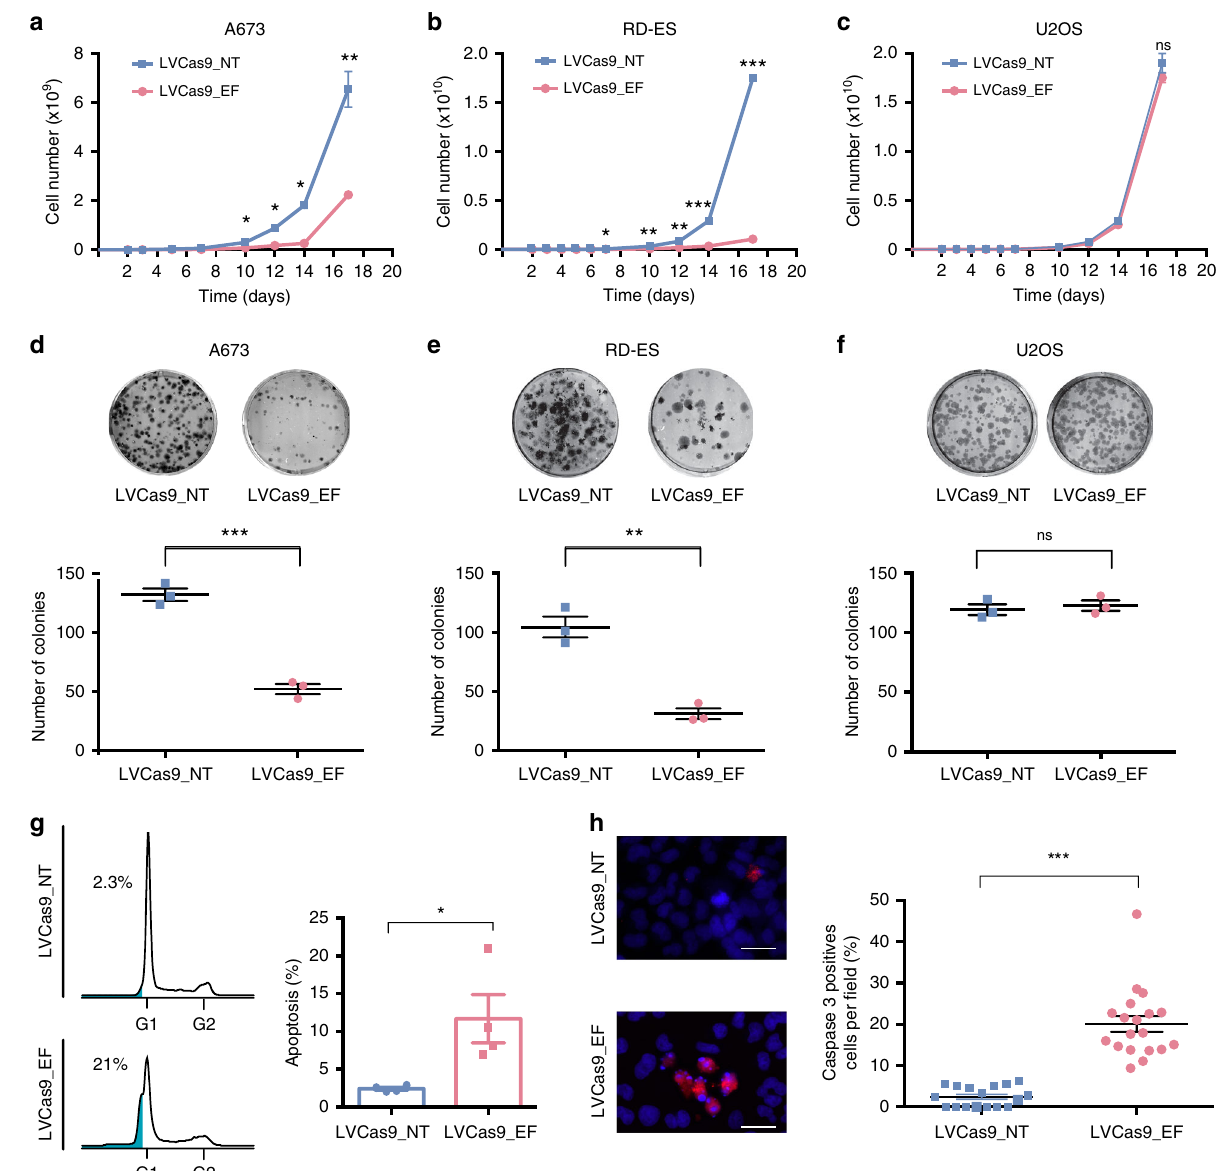
Fig. 2 CRISPR-mediated targeting of EWSR1-FLI1 inhibits in vitro cell growth. a – c Growth rate assay curves of A673 (** p = 0.01), RD-ES (*** p = 0.0005) and U2OS edited (LVCas9_EF) and control (LVCas9_NT) cells. ( n = 6 independent experiments). d – f Representative crystal violet staining of A673 (*** p = 0.0003), RD-ES (** p = 0.0017) and U2OS experimental and control cells. Bottom panels show the statistical analysis of the number of colonies. ( n = 3 independent experiments). g Left panel shows DNA pro fi le analysis by propidium iodide staining and fl ow cytometry. FlowJo v10.0.7 fl ow cytometry analysis of DNA fragmentation by subG1 population (cells with fragmented DNA) quanti fi cation. The percentage of cellular apoptosis was calculated using the percentage of the subG1 peak. Right panel shows graphical representation of subG1 analysis. ( n = 4 independent experiments) * p = 0.027. h Representative images of caspase-3-immunostained A673 cells. Scale bars, 50 μ m. Right panel shows the percentage of caspase-3-positive cells per fi eld analyzed. ( n = 520 (LVCas9_NT) and n = 613 (LVCas9-EF) cells examined over three independent experiments), *** p = 1.07e-9. The error bars indicate the s.e.m. for the averages across the multiple experiments; p -values are represented (ns non-signi fi cant; * p ≤ 0.05; ** p ≤ 0.01; *** p ≤ 0.001). Statistical are two-tailed unpaired t